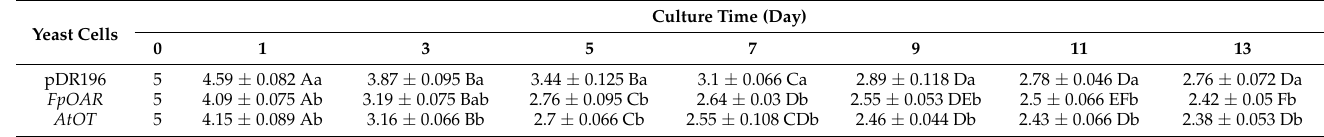
Table 1. Variation of culture solution pHs for different recombinant yeast cells under 2 mM oxalic acid stress.